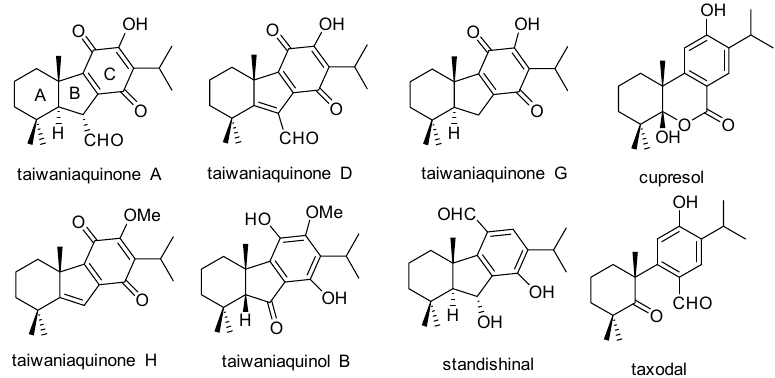
Figure 1. Representative taiwaniaquinoids and related metabolites.